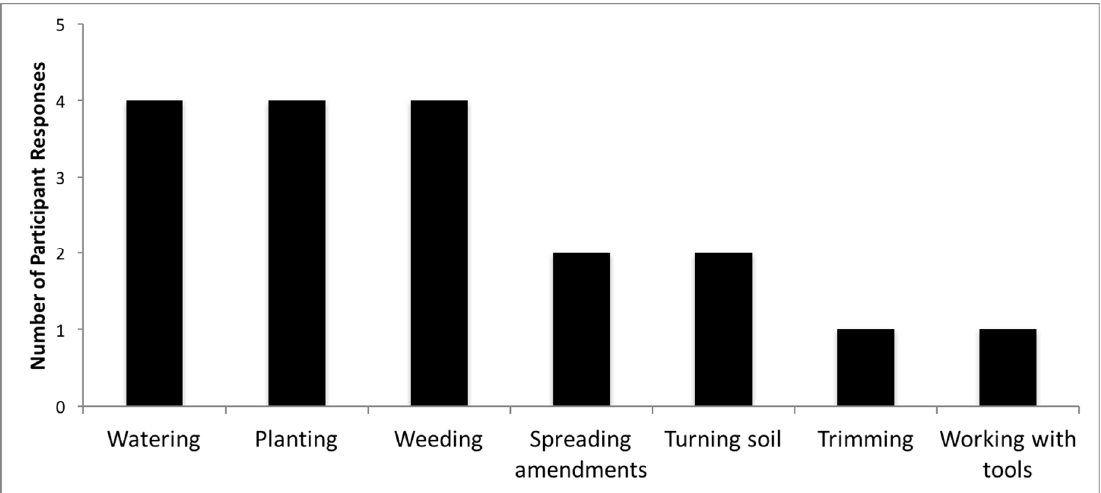
Figure 1. Participant activities in garden and contact with soil.